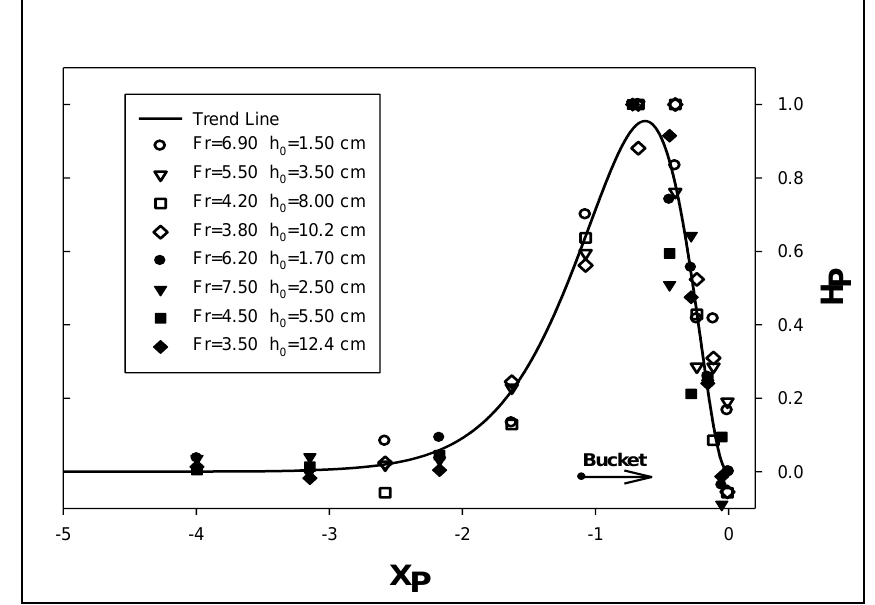
Figure 11. Variation of dynamic pressure H P along the centerline bed of the bucket X P (r 2 =0.91)